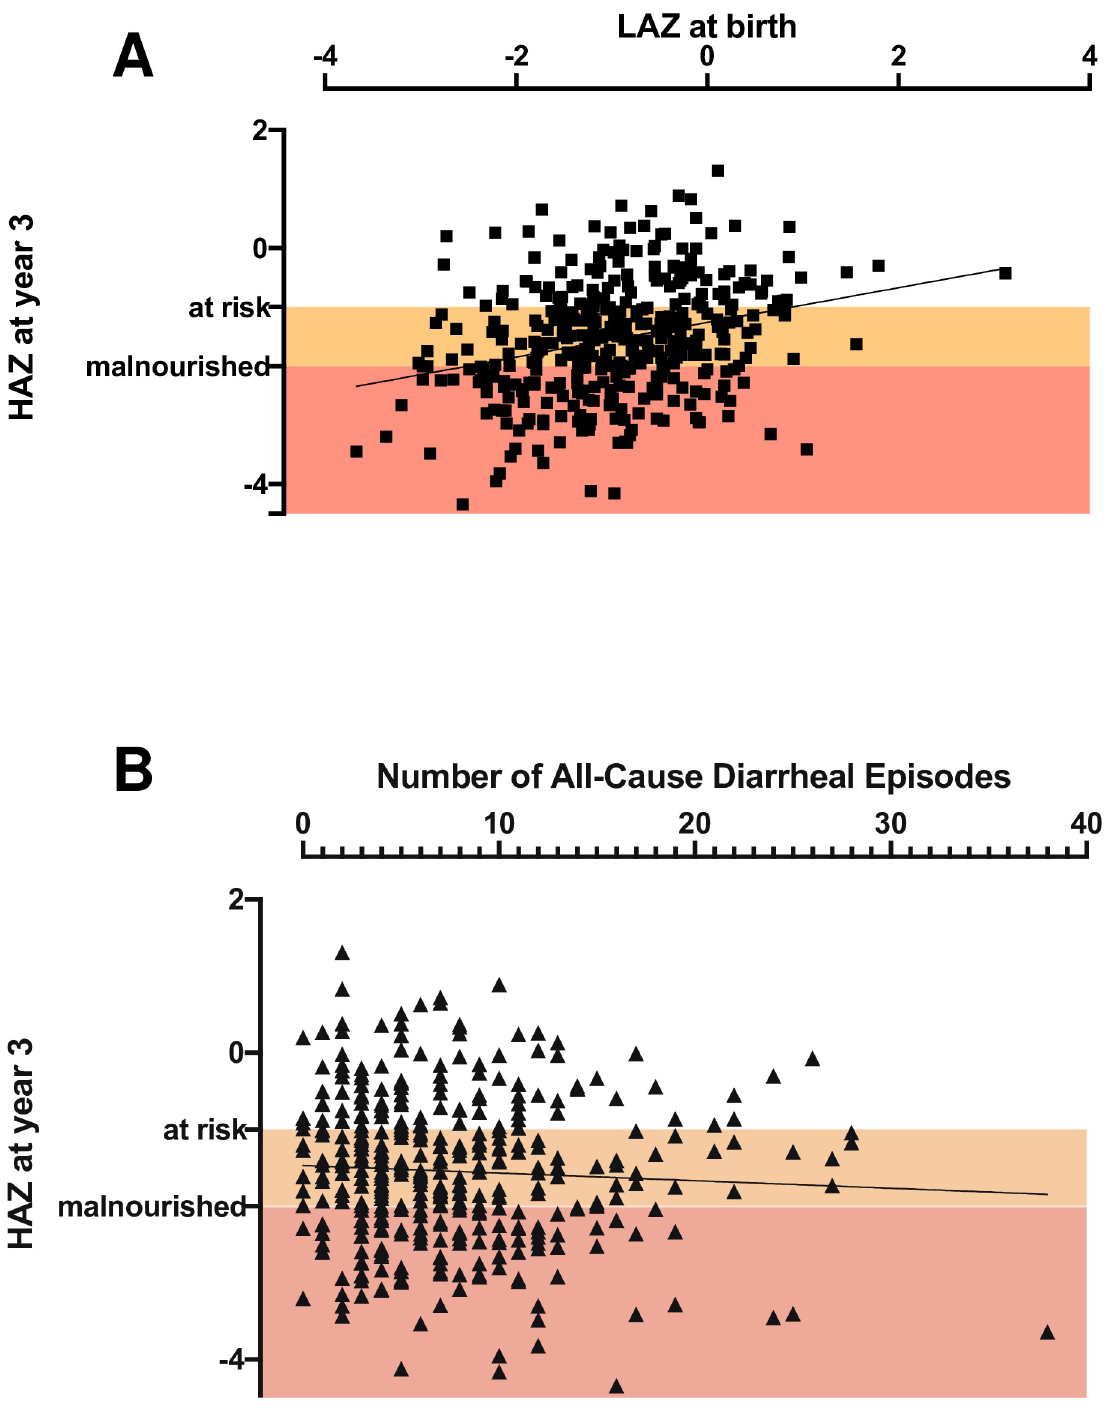
Fig 5. Correlates of cryptosporidiosis-associated growth-faltering. A) Comparison of three year-HAZ with birth LAZ. (Slope: -0.294 ± 0.05; R squared value: 0.08; Significance p < 0.0001). B) Relationship of all-cause diarrhea with HAZ at 3 years of age (p = NS).